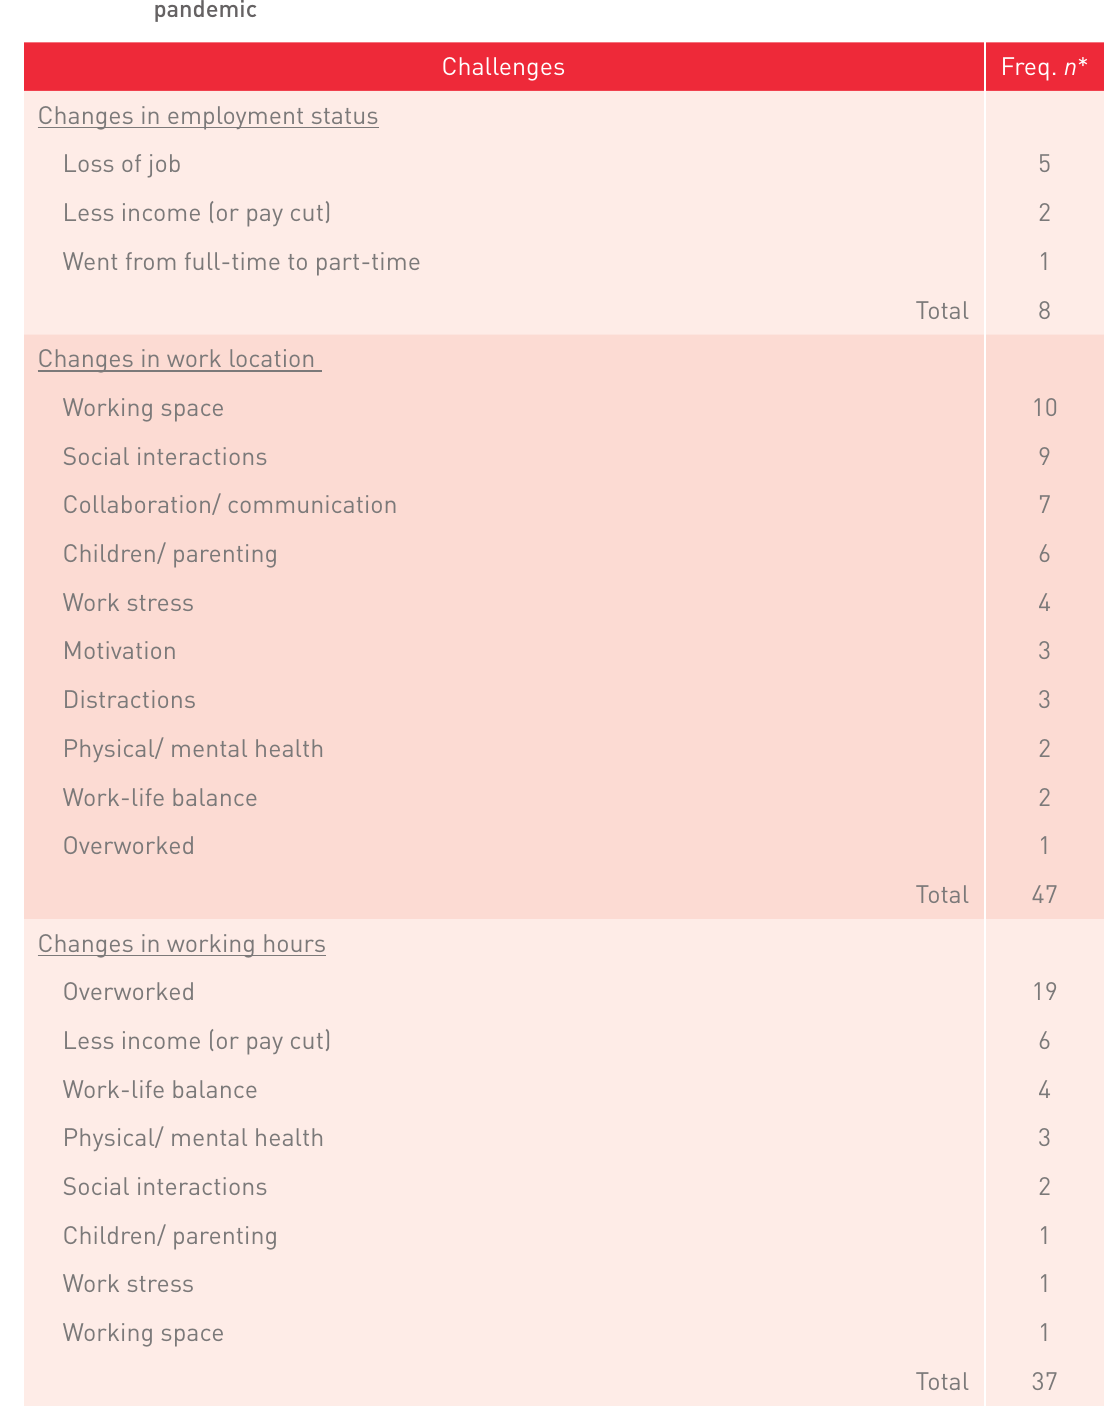
Table 3. The challenges associated with the changes in the respondents’ job situations during the pandemic Challenges Freq. n * Changes in employment status Loss of job 5 Less income (or pay cut) Went from full-time to part-time